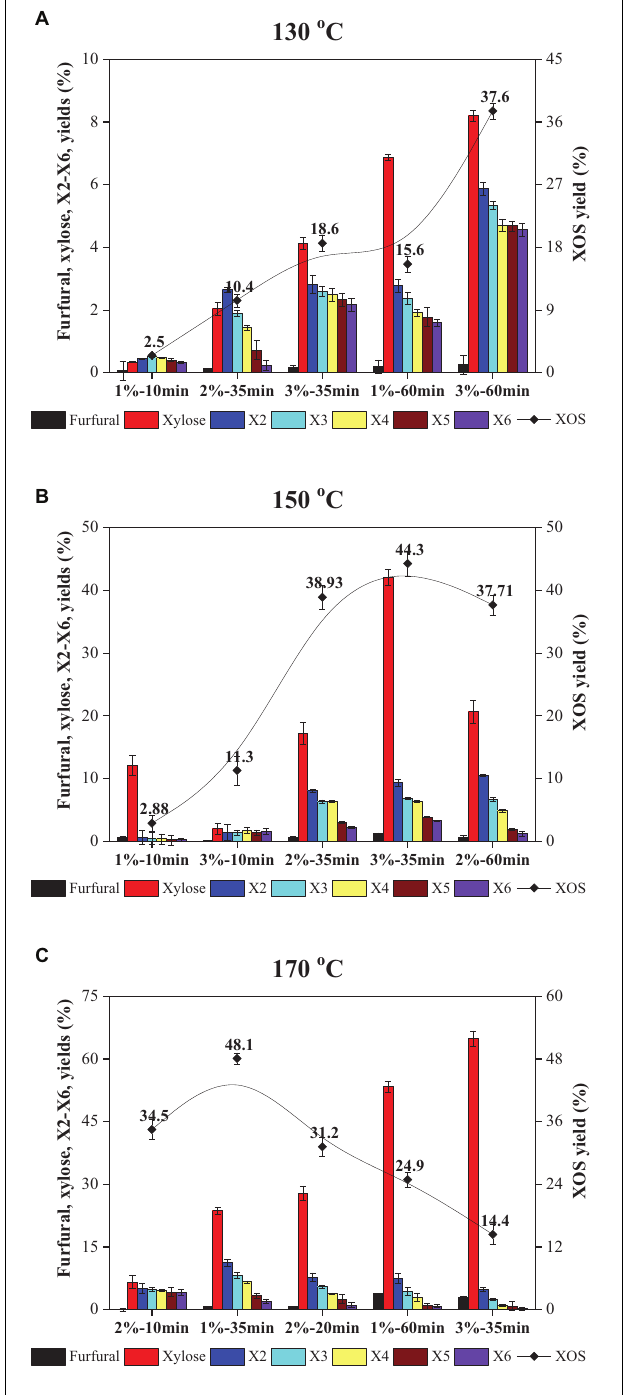
FIGURE 1 | Yields of furfural, xylose, X2–X6, and XOS in FA hydrolyzate of xylan at different FA concentrations, times, and temperatures: (A) 130 ◦ C; (B) 150 ◦ C; and (C) 170 ◦ C. XOS, xylooligosaccharides; FA, furoic acid.